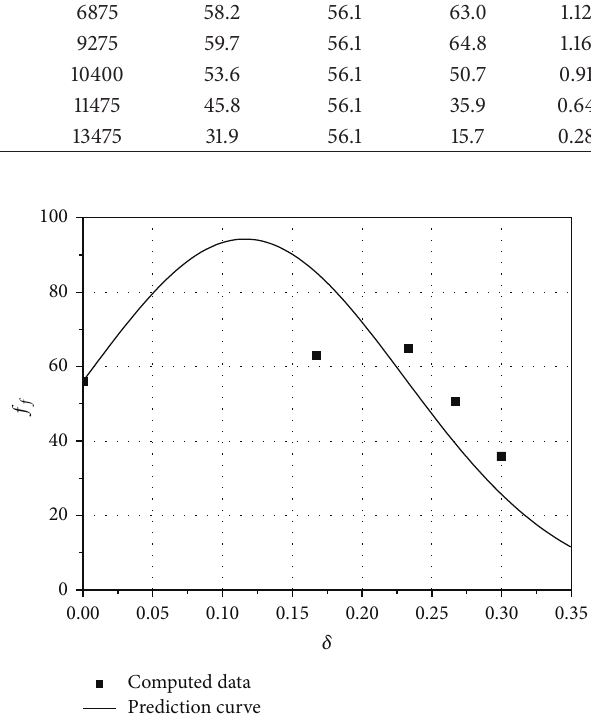
Figure 12: Strength of corroded layer and predicted